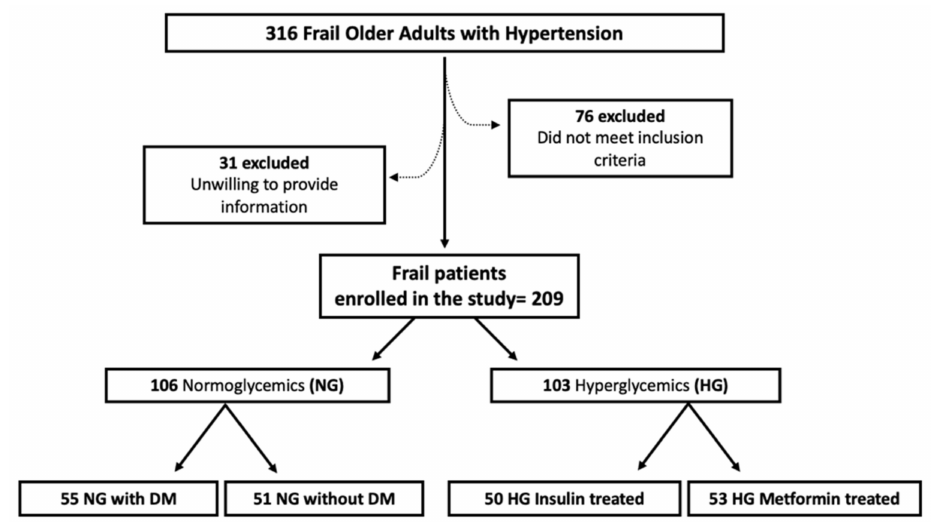
Figure 1. Study Flow Diagram. DM: diabetes mellitus; HG: hyperglycemic; NG: normoglycemic. Table 1. Clinical characteristics of our